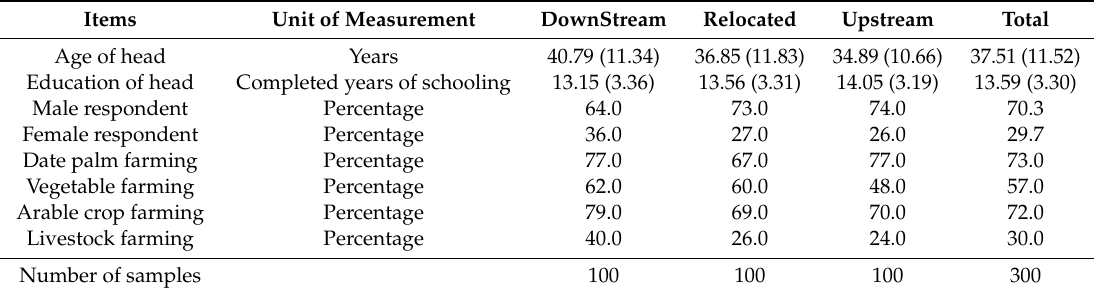
Table 1. Summary statistic of the demographic characteristics in three